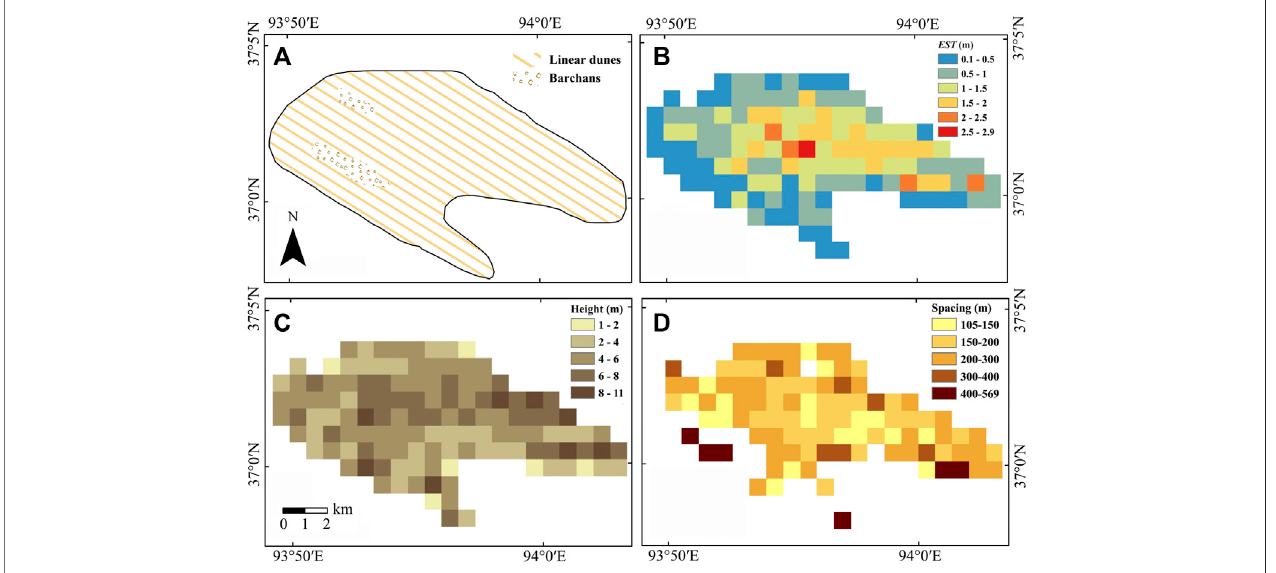
FIGURE 10 | Maps of the (A) dune distribution, (B) equivalent sand thickness ( EST ), (C) dune crest height, and (D) crest to crest dune spacing for area A2 (Figure 1) .